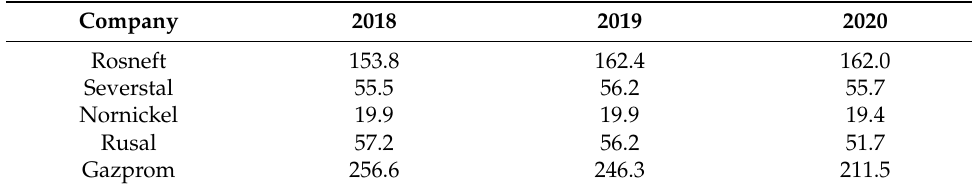
Table 2. Cost of emissions, billion rubles.